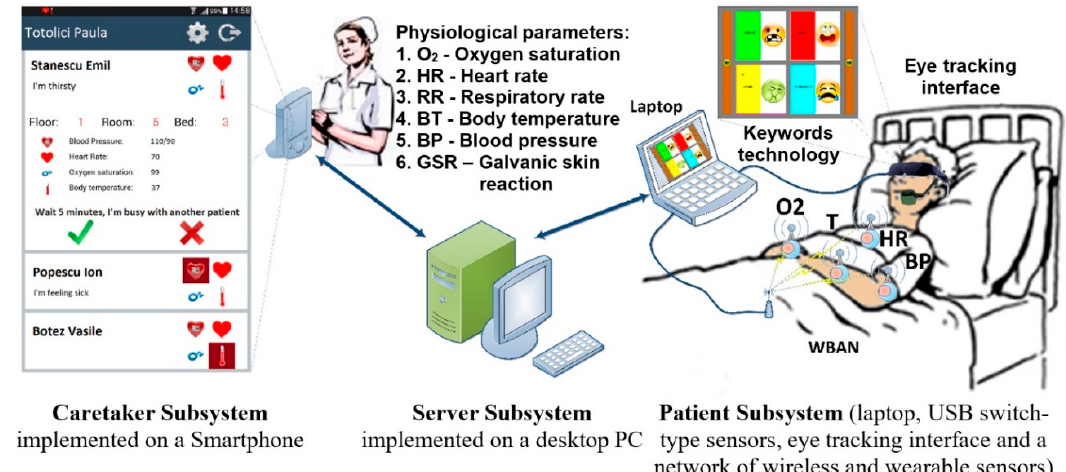
Figure 1. Structure of the proposed integrated system for assistance in communicating with and telemonitoring severely disabled patients.